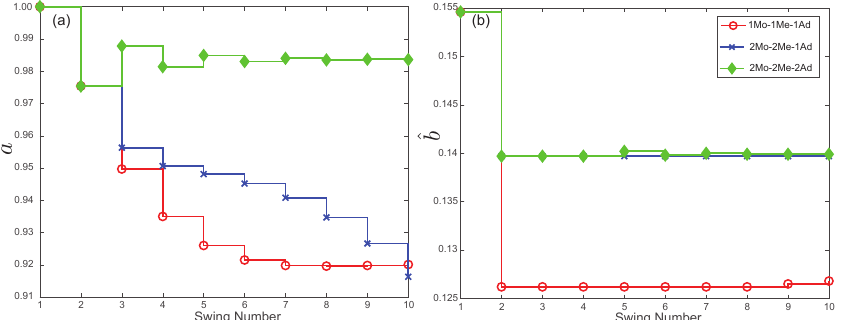
Figure 5. Adaptations of the parameters ( a ) ˆ a and ( b ) ˆ b as a function of the swing number for all three